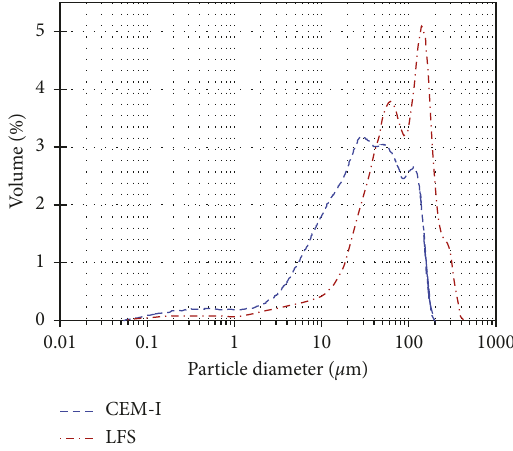
Figure 6: Particle size distribution of CEM-I and raw LFS.